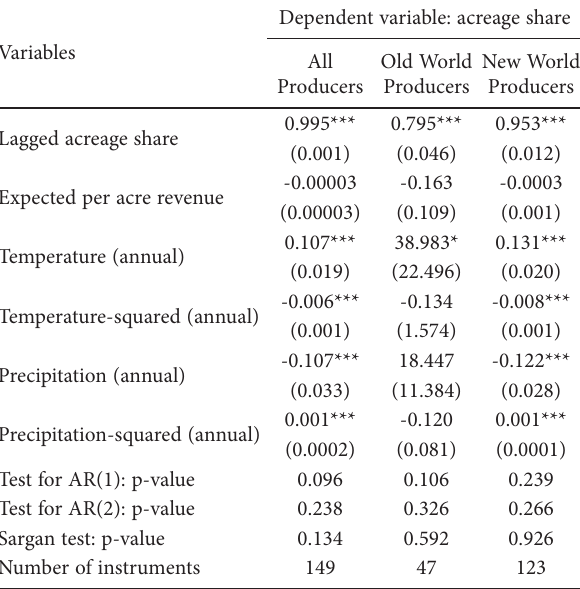
Table 4. Estimation results for grapevines acreage, Old World Pro- ducers and New World